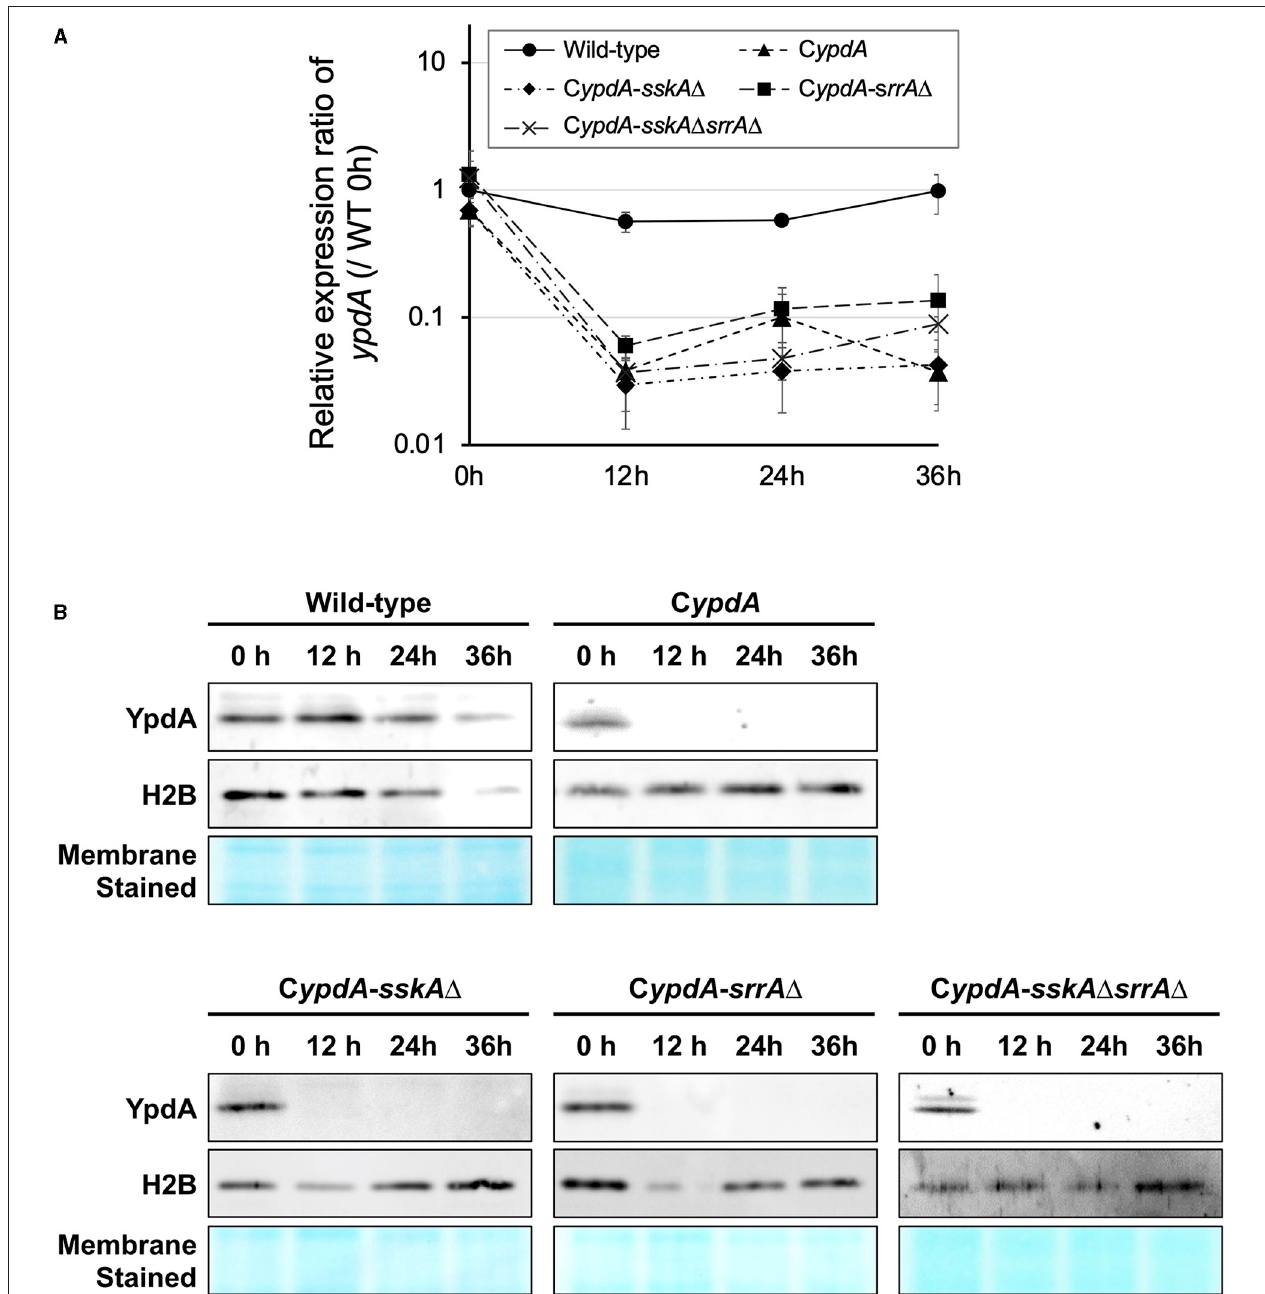
FIGURE 1 | Downregulation of the ypdA gene (A) and YpdA protein levels (B) in Aspergillus nidulans wild-type, C ypdA , and C ypdA -derivative strains. (A) Time course of ypdA expression after transfer from ypdA -inducing medium (CDTFY; 0h) to ypdA -repressing medium (CDY). Conidia (final concentration, 5 × 10 5 conidia/ml) were inoculated into ypdA -inducing medium and cultured for 20h before transfer to ypdA -repressing medium, at 0h. Samples were prepared from mycelia at 12, 24, and 36h, and ypdA expression was quantified by RT-PCR. The expression level of the ypdA gene in each sample was normalized to that of the histone H2B gene (internal control) in the same sample. Each value represents the ypdA expression ratio relative to expression in the wild-type strain cultured in CDTFY medium for 20h (WT 0h). Error bars represent standard deviations from three independent replicates. (B) Western blot analysis of YpdA protein with histone H2B protein as an internal standard and stained membrane for confirmation of protein transfer. Samples were prepared from mycelia at 12, 24, and 36h after transfer from ypdA -inducing medium (CDTFY; 0h) to ypdA -repressing medium (CDY). Each lane was loaded with 15 µ g protein.